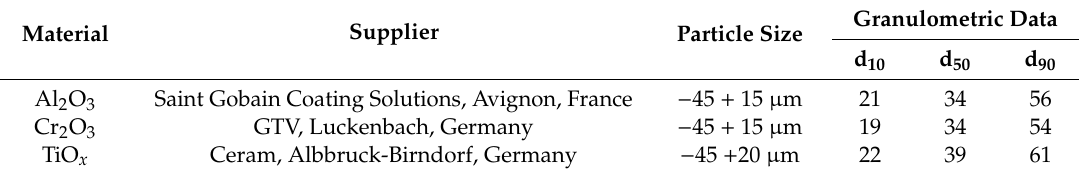
Table 1. Commercial single oxide feedstock powder grades, their particle size given by the supplier, and their granulometric data (own measurement). All powders were produced by fusing and crushing.